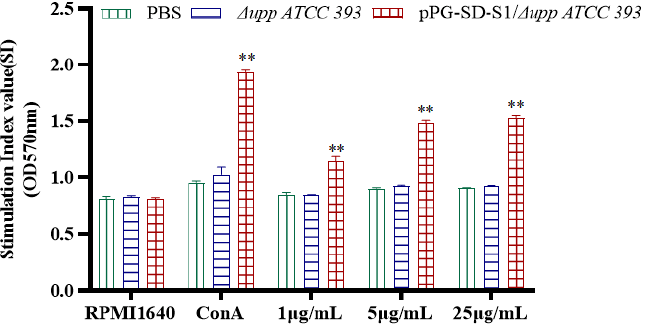
Figure 7. Lymphocyte proliferation in immunized mice was determined by the 3-(4,5-dimethylthiazol-2-yl)-2,5-diphenyltetrazolium bromide (MTT) assay. With purified PEDV S1 protein as the stimulation source, the stimulation index of spleen lymphocytes isolated from immunized mice was detected by the MTT assay. Bars represent mean ± standard error in each group (** p < 0.01, compared to controls: PBS and ∆ upp ATCC 393 ).